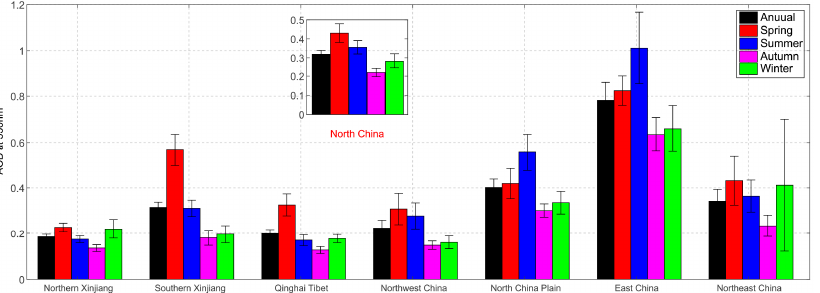
Figure 3. Annual and seasonal mean values of MODIS AOD for the period 2001–2016 in North China and the seven regions (see Figure 1). and the seven regions (see Figure 1).